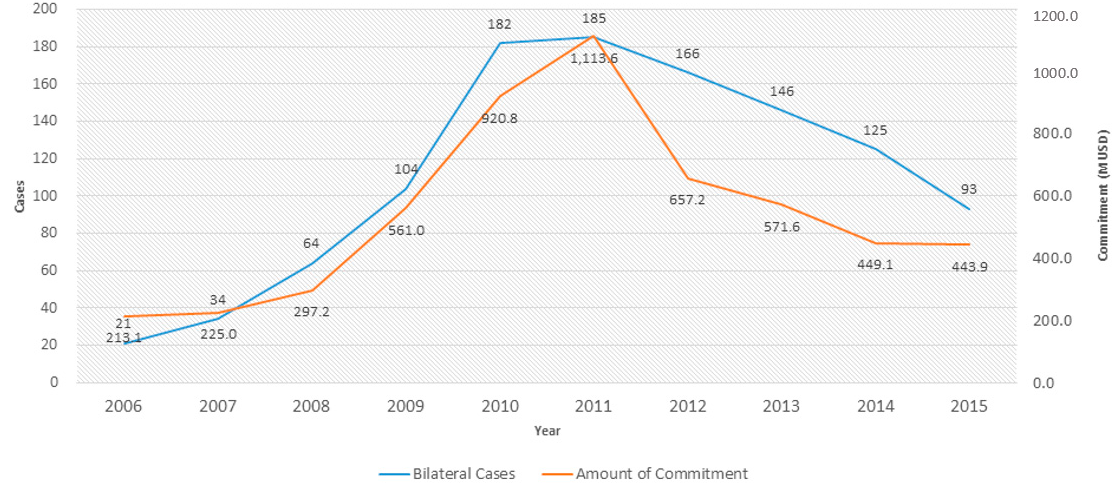
Figure 1. Trends in bilateral REDD + project cases and amount of commitment between 2006–2015.